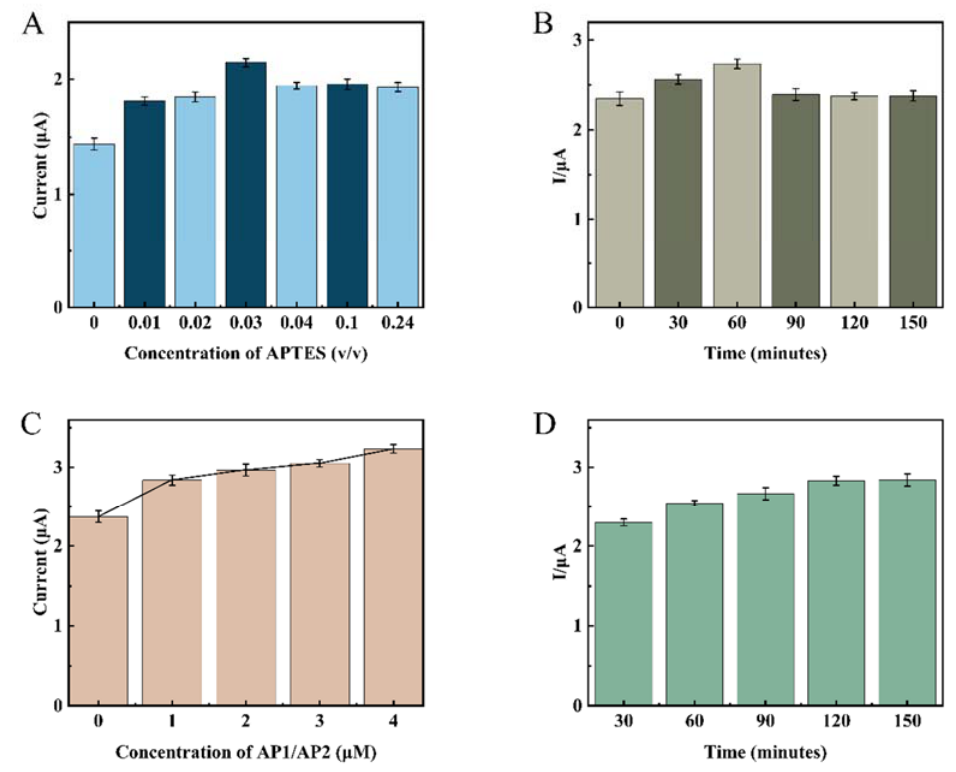
Figure 5. Optimization of each necessary experimental factor. ( A ) Concentration of the APTES; ( B ) APTES reaction time; ( C ) concentration of the AP1 and AP2; ( D ) incubation time of AP1 and AP2. The concentration of CP and TD was 1 μ mol/L.